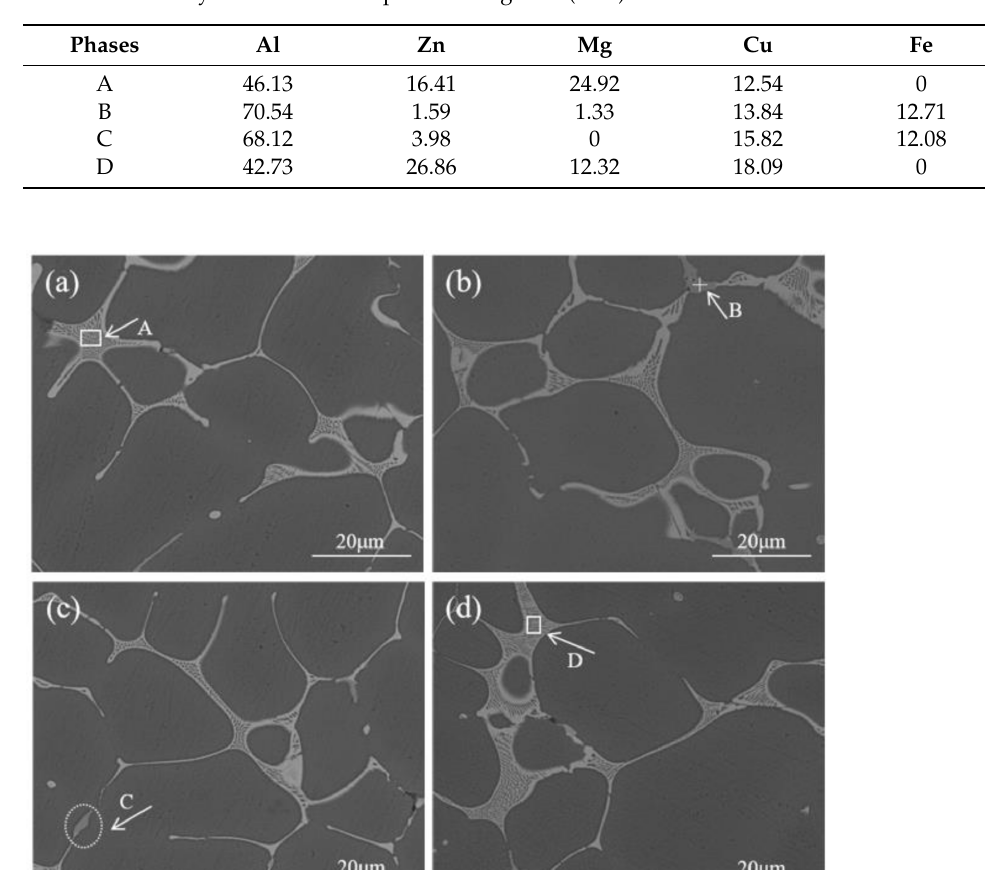
Table 3. EDS analysis of constituent phases in Figure 6 (at.%).